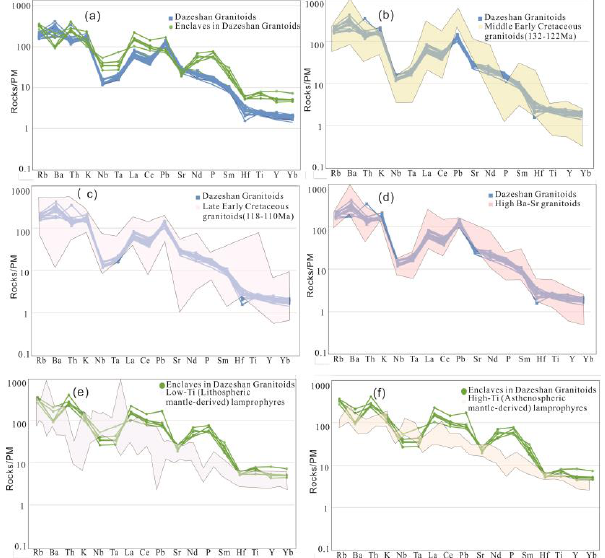
Figure 7. Comparison of primitive mantle-normalized spider diagrams between granitoids of the Dazeshan and their enclaves ( a ), Dazeshan granitoids and middle Early Cretaceous granitoids (132 – 122 Ma) ( b ), Dazeshan granitoids and late Early Cretaceous granitoids (118 – 110 Ma) ( c ), Dazeshan granitoids and high Ba – Sr granitoids ( d ), Dark microgranular enclaves and low-Ti (Lithospheric mantle-derived) lamprophyres ( e ), and Dark microgranular enclaves and high-Ti (Asthenospheric mantle-derived) lamprophyres ( f ). The published data for middle Early Cretaceous granitoids (132 – 122 Ma) are from [64,30,65,66], for Late Early Cretaceous granitoids (118 – 110 Ma) from [49,67,50], for high Ba – Sr granitoids from [24], and for low-Ti and high-Ti lamprophyres from [47].